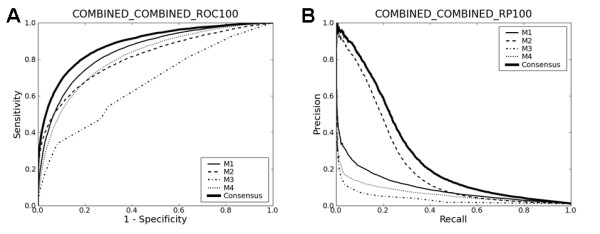
Cross-validation on the combined data. The title of each plot reads in the same way as in Fig. 1.